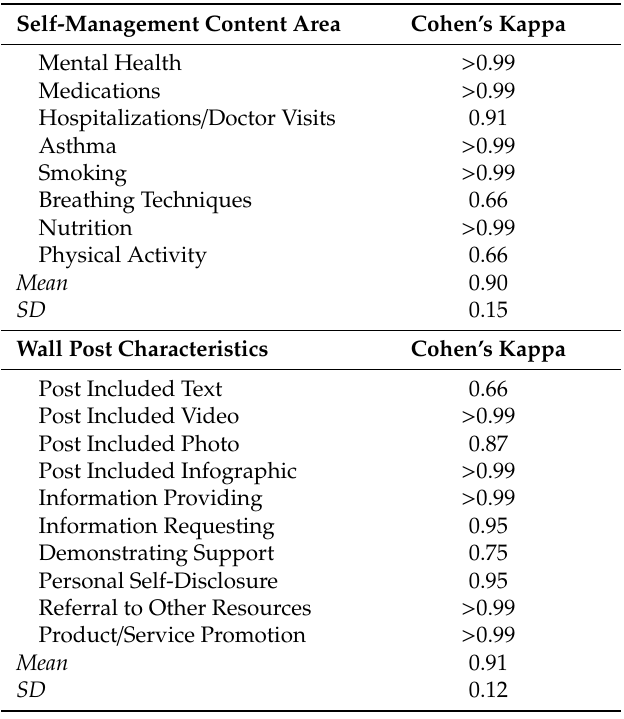
Table 2. Intercoder reliability scores for self-management content areas and characteristics of Chronic Obstructive Pulmonary Disease (COPD) group wall posts ( n =